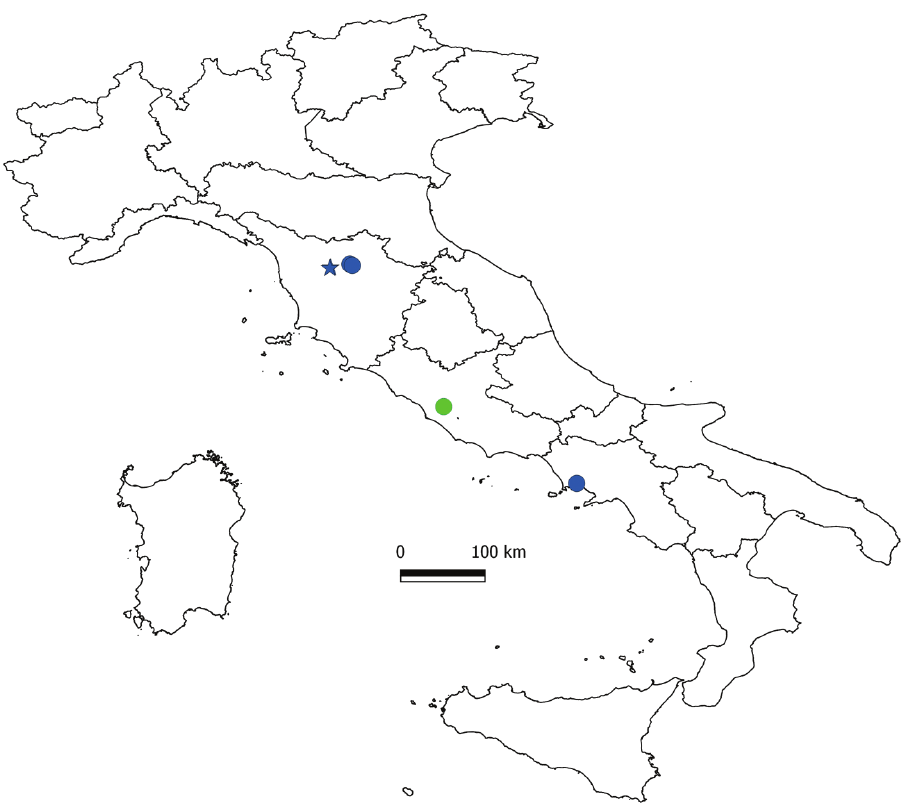
Figure 3. Distribution map of Crocus biflorus var. estriatus , based on historical herbarium specimens (blue dots) and historical literature (green dots). The blue star represents the newly discovered population (Empoli), which is also the only currently